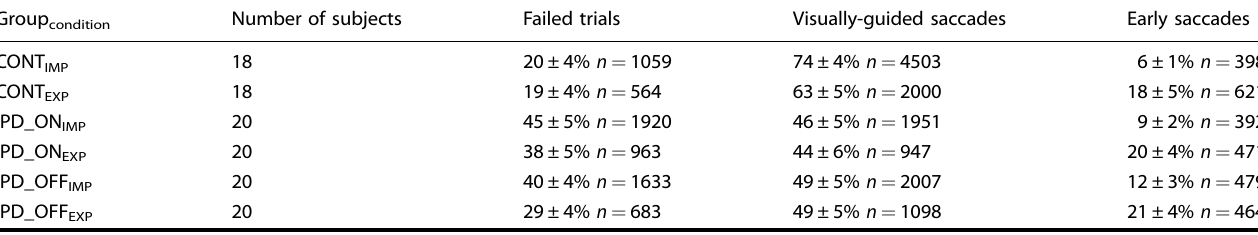
Table 2. Summary.